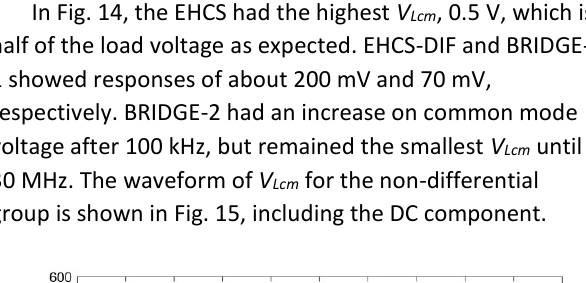
Fig.14: Simulated common mode load voltage ( V Lcm ) of the non- differential EHCS for a load of 1 kΩ.